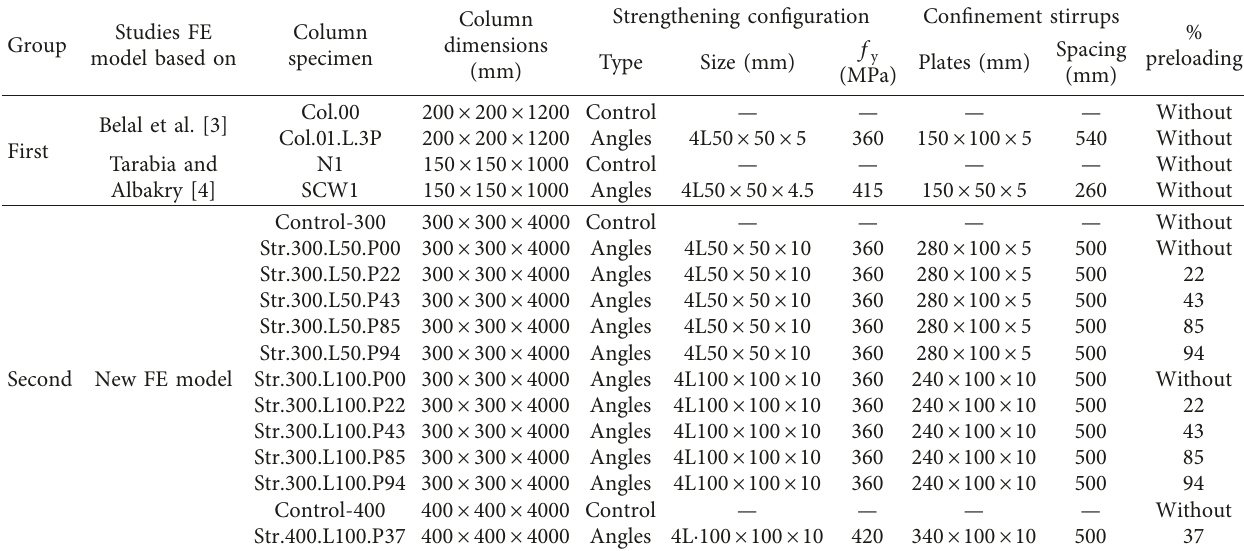
Table 2: Summary of RC columns reinforced with steel jacketing in the present